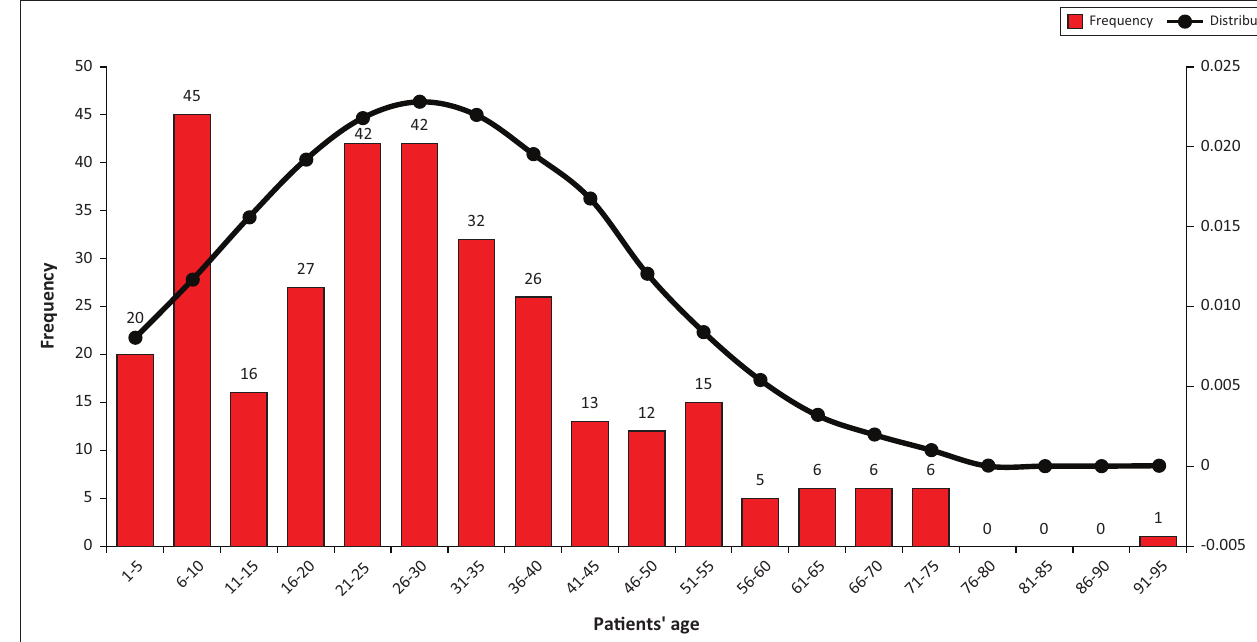
FIGURE 1: Breakdown of completed data collection sheets by healthcare professionals.